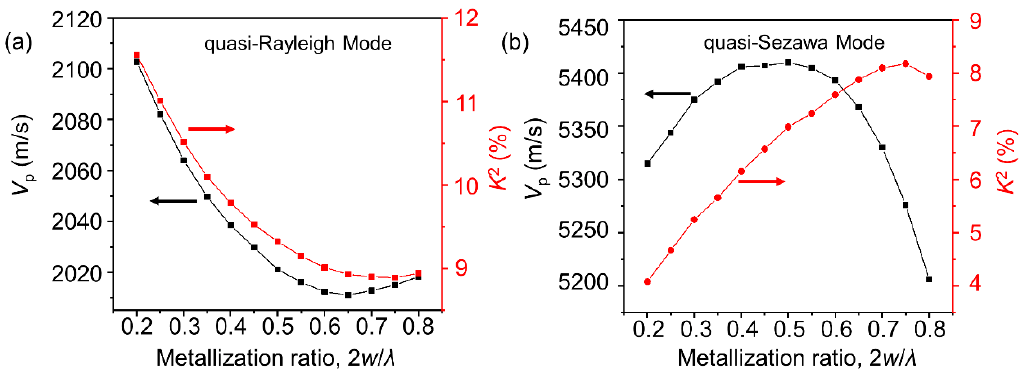
Figure 6. V p and K 2 as functions of metallization ratio 2w/ λ of ( a ) quasi-Rayleigh mode and ( b ) quasi-Sezawa mode.